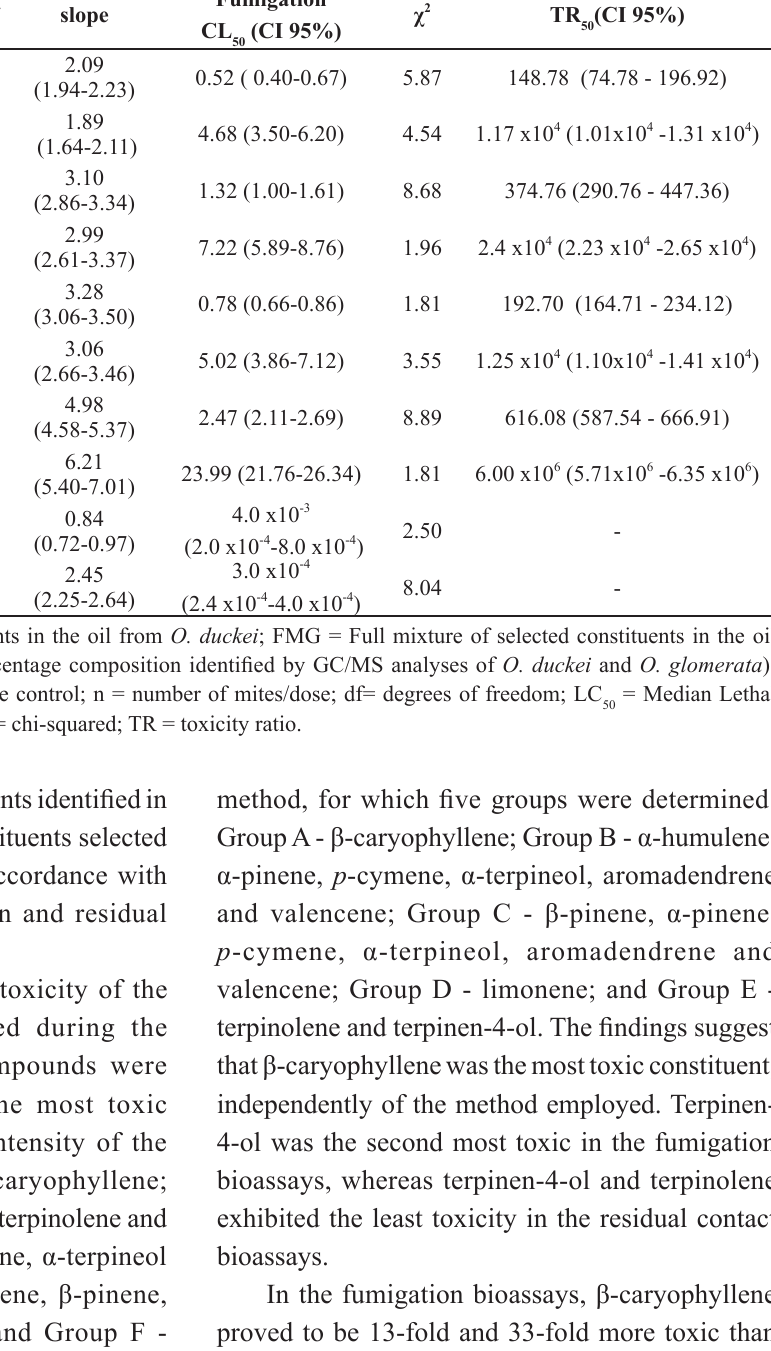
at μL mL -1 ) of the blends of selected constituents and 50